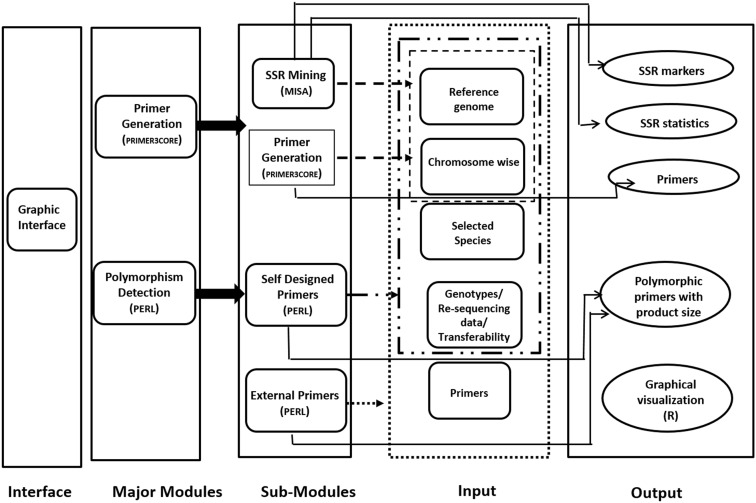
Schematic representation of PolyMorphPredict for microsatellite mining, primer designing, and polymorphism discovery.